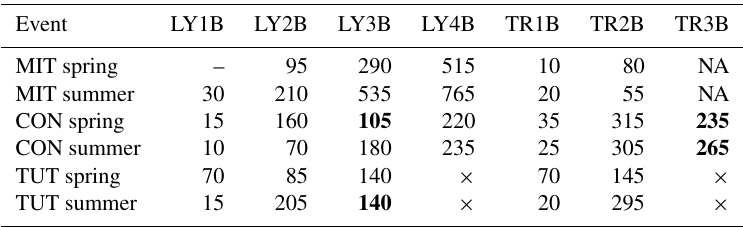
Table 4. Time to 20% rise in SSF (min) for all flow components and all sprinkling experiments. The “–” indicates that time to 20% rise in SSF could not be calculated due to missing data at the beginning of the event (MIT in spring), × indicates that this LY or TR did not exist (TUT), and NA indicates that this lysimeter or trench yielded no flow (MIT). Numbers in bold indicate cases when a flow component at a deeper soil depth responded earlier than a flow component at a shallower soil depth.